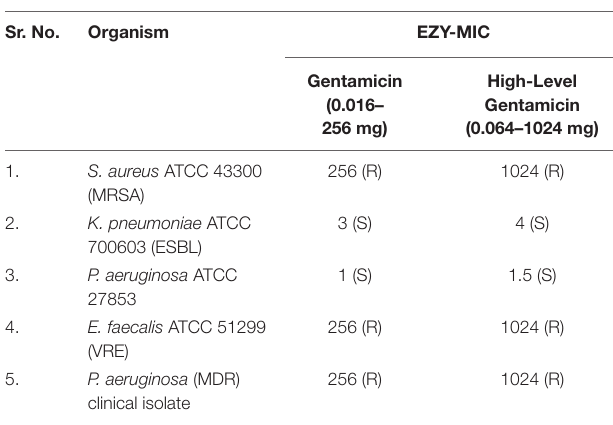
TABLE 4 | E -test MIC for